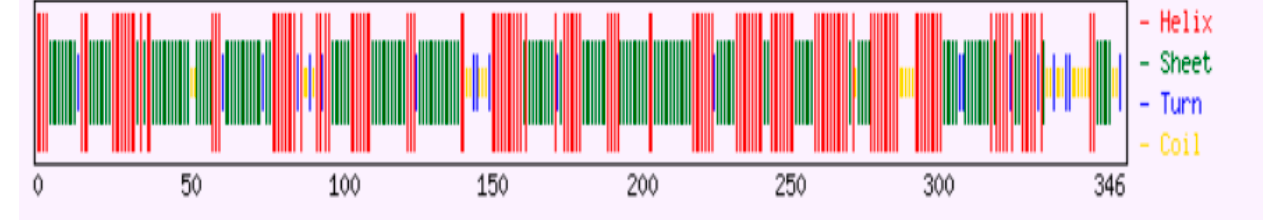
Figure 2. CFSSP result.